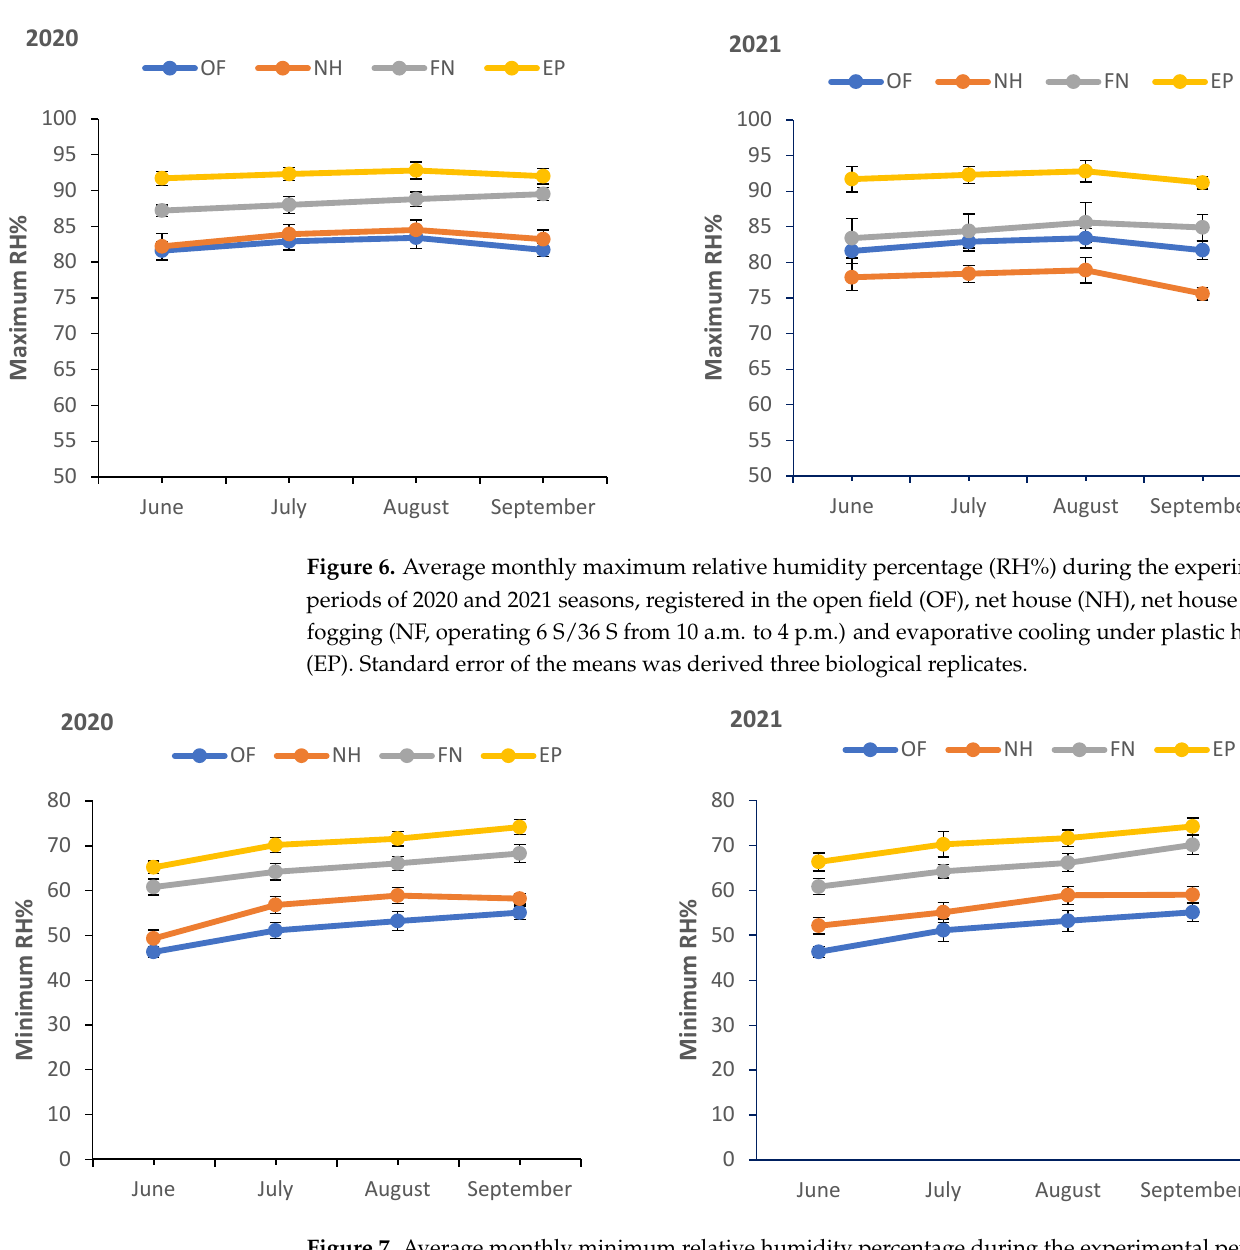
Figure 7. Average monthly minimum relative humidity percentage during the experimental peri-